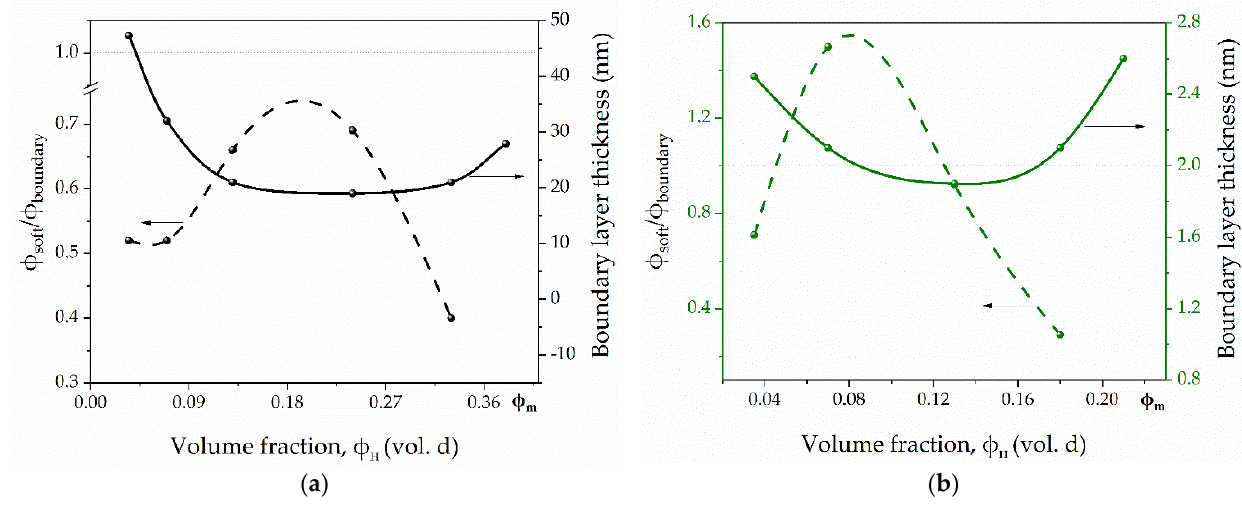
Figure 6. Dependence of φ t / φ b and δ on the volume fraction of the filler φ f in the samples PU/SiC_neat ( a ) and PU/SiC@C/NW ( b ).